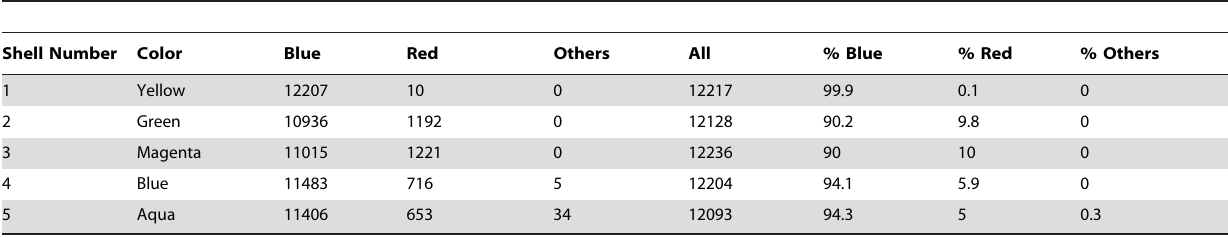
Table 1. Partitioning of the nucleus into concentric ellipses: The areas are computed by the number of pixels as shown in Fig. 2c.